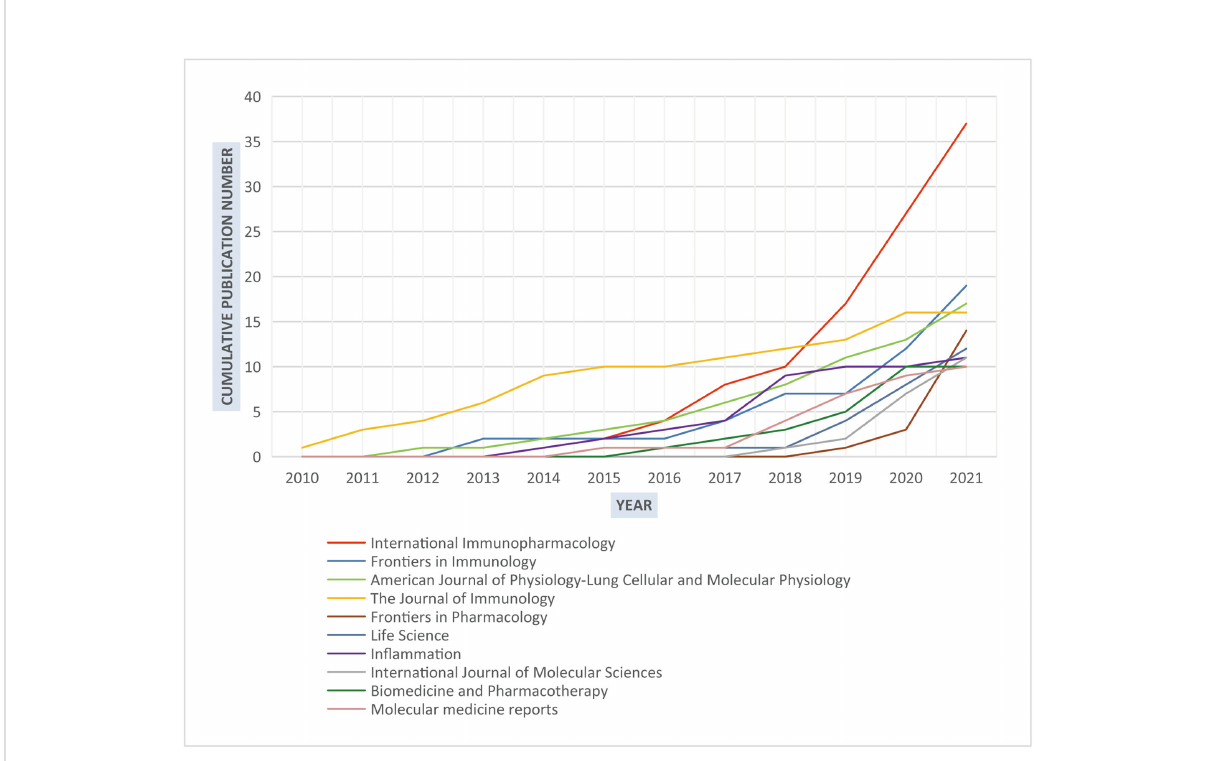
FIGURE 3 The growth trend of publications in the top 10 productive journals.